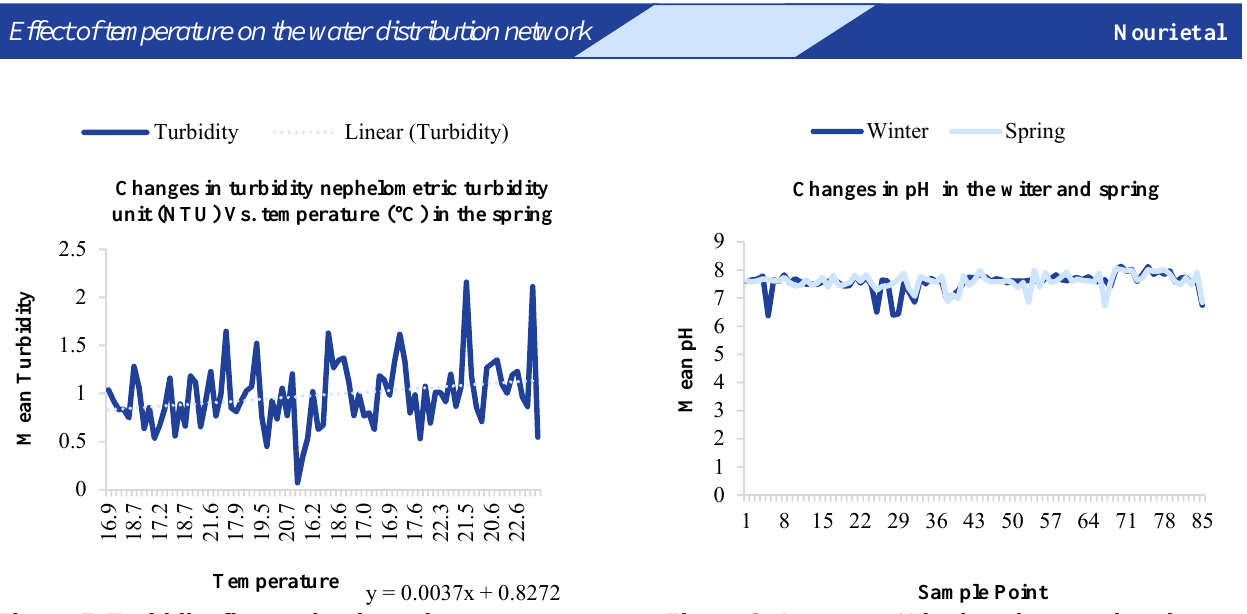
Figure 7. Turbidity fluctuation in spring Paired